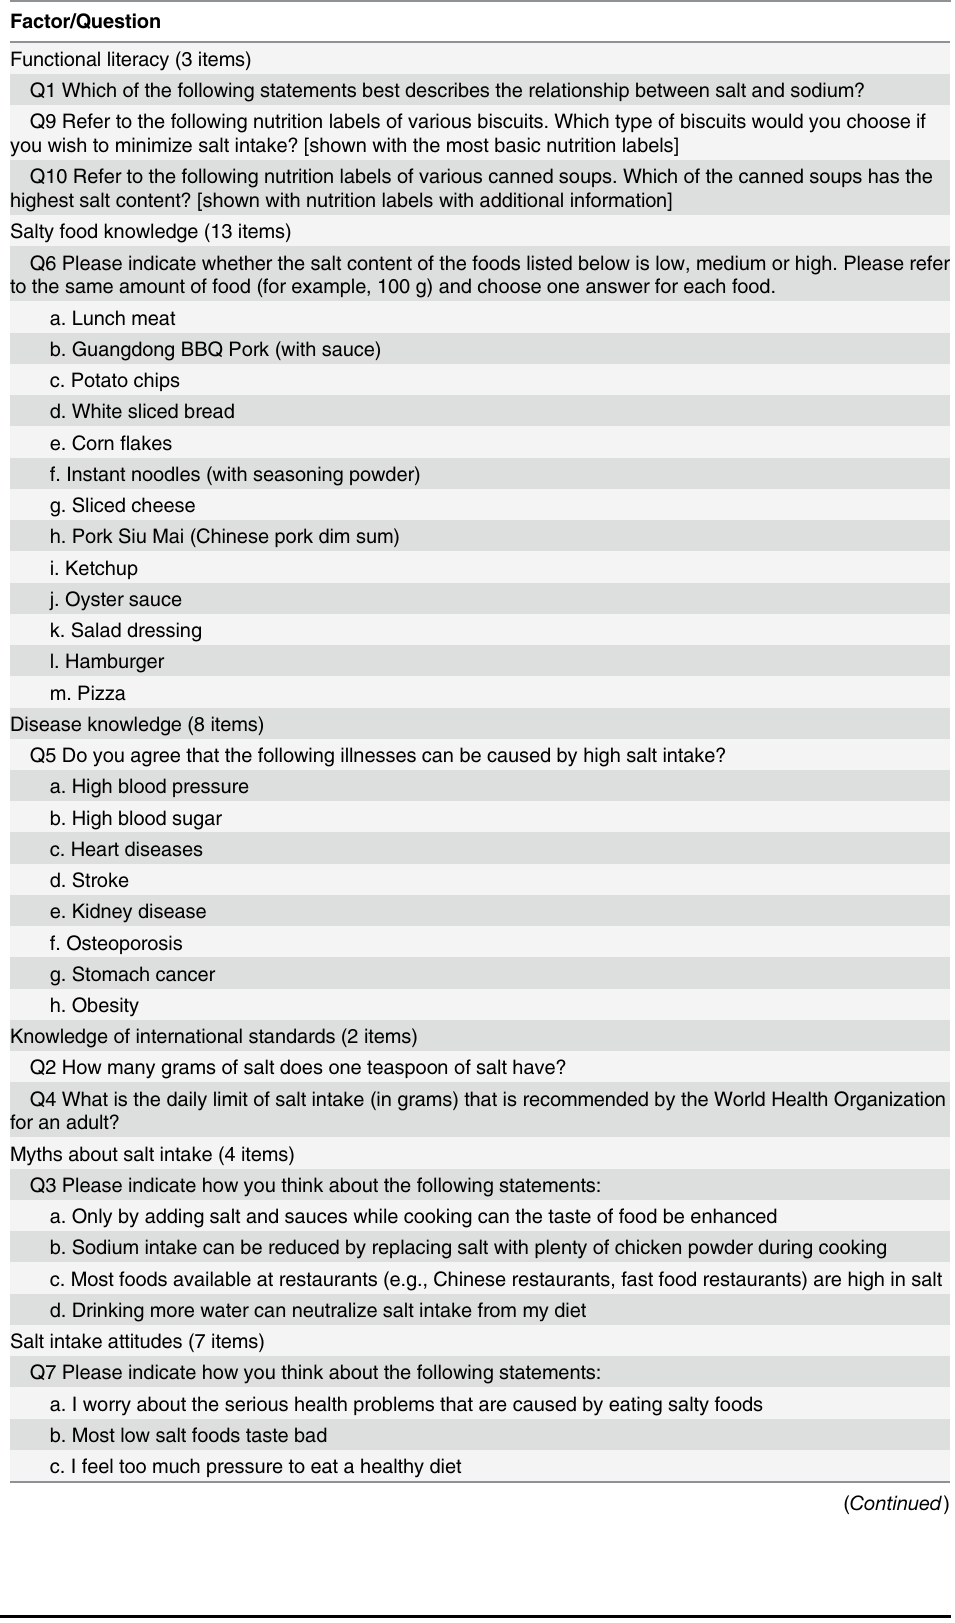
Table 2. Questions and factors on the Chinese Health Literacy Scale for Low Salt Consumption — Hong Kong version (CHLSalt-HK) and standardized